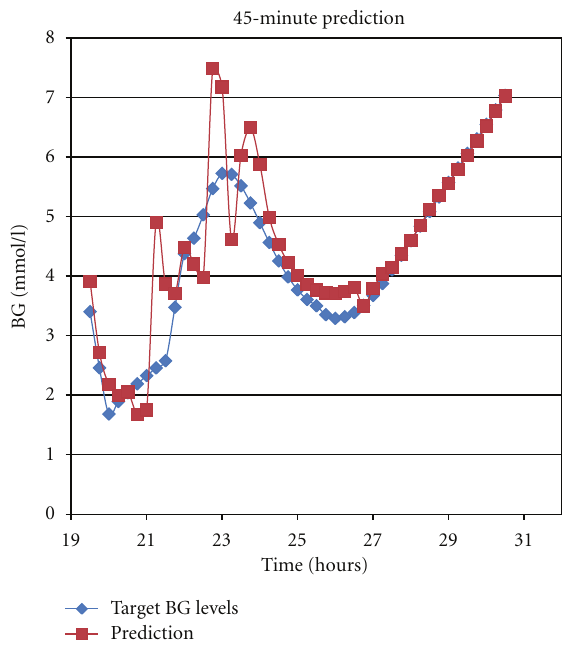
Figure 6: 45-minute prediction results from a day of data not used during AIDA